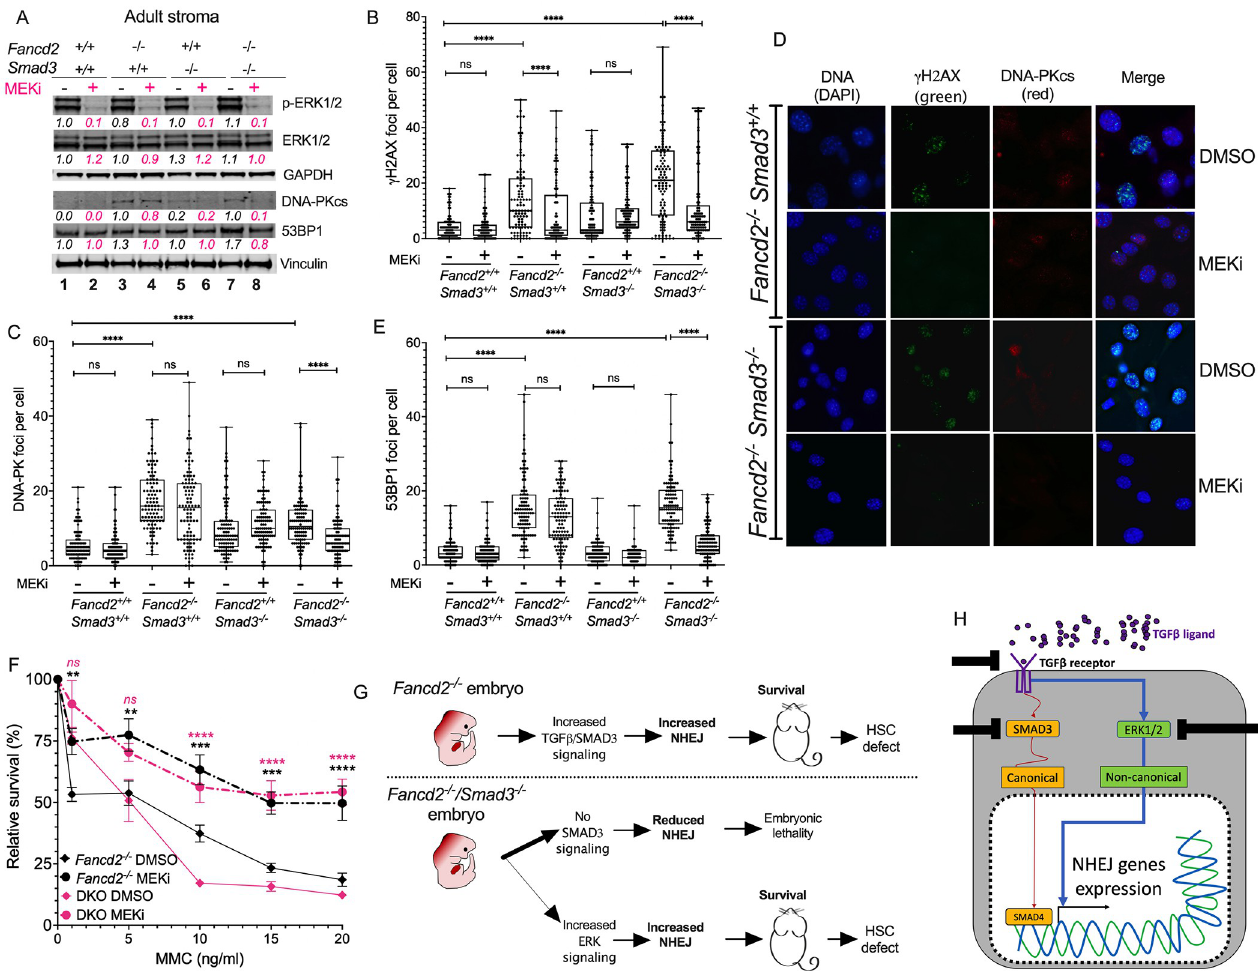
Fig 5. Inhibition of ERK in surviving Smad3 Fancd2-129B6F2 mice stroma reduces NHEJ proteins and improves DNA repair. (A) Western blots of the lysates from bone marrow stromal cells showing that inhibition of ERK phosphorylation with the MEK inhibitor PD0325901 reduces the levels of DNA-PKcs in DKO cells but not in Fancd2 -/- cells. A representative blot from three independent experiments is shown. Quantification relative to wild type in basal conditions and the loading control is shown below every lane. Pink indicates samples treated with MEKi PD0325901. (B) Quantitation of γ H2AX foci by immunofluorescence showing that the MEK inhibitor PD0325901 reduces the number of γ H2AX foci in Fancd2 -/- cells and DKO cells. (C) Quantitation of DNA-PKcs foci by immunofluorescence showing that the MEK inhibitor PD0325901 significantly reduces the number of DNA-PKcs foci in DKO cells. (D) Representative images of γ H2AX foci and DNA-PKcs foci in Fancd2 -/- and DKO stromal cells after exposure with MEK inhibitor PD0325901. (E) Quantitation of 53BP1 foci by immunofluorescence showing that the MEK inhibitor PD0325901 significantly reduces the number of 53BP1 foci in DKO cells. (F) Survival curves of bone marrow stromal cells showing that the MEK inhibitor PD0325901 rescues Fancd2 -/- and Smad3 Fancd2-129B6F2 stromal cells from MMC toxicity. Response of the WT and Smad3 -/- cell lines is shown in S5D Fig. (G) Working model. Upper panel . FA mouse embryos depend on the canonical TGF β -SMAD3 pathway for activating the expression of DNA-PKcs and perform NHEJ thus allowing Fancd2 -/- embryo survival in absence of a functional FA pathway. Lower panel . Absence of the FA pathway and the canonical SMAD3 pathway is embryonic lethal, however a small fraction of Smad3 Fancd2-129B6F2 embryos activate the non-canonical ERK pathway thus circumventing embryonic death. In both cases surviving mice present with defective hematopoietic stem cells in the bone marrow. (H) Schematics showing that the TGF β ligands and TGF β receptors can engage the canonical (SMAD3) or the non-canonical (ERK1/2) pathways and activate expression of NHEJ genes. Upon inhibition of the canonical TGF β pathway, activation of the non-canonical ERK pathway occurs. This possess the potential emergence of resistance to TGF β pathway inhibitors or refractory to treatment patients, therefore combining TGF β pathway inhibitors, to avoid the emergence of resistance, has to be considered for designment of future clinical trials. Data in (B), (C) and (E) are represented as boxplots. Data in (F) are represented as mean ± SEM. p values of 0.01 to 0.05 were considered significant ( � ), p values of 0.001 to 0.01 were considered very significant ( �� ) and p values of < 0.001 were considered extremely significant ( ��� , ���� ). See also S5